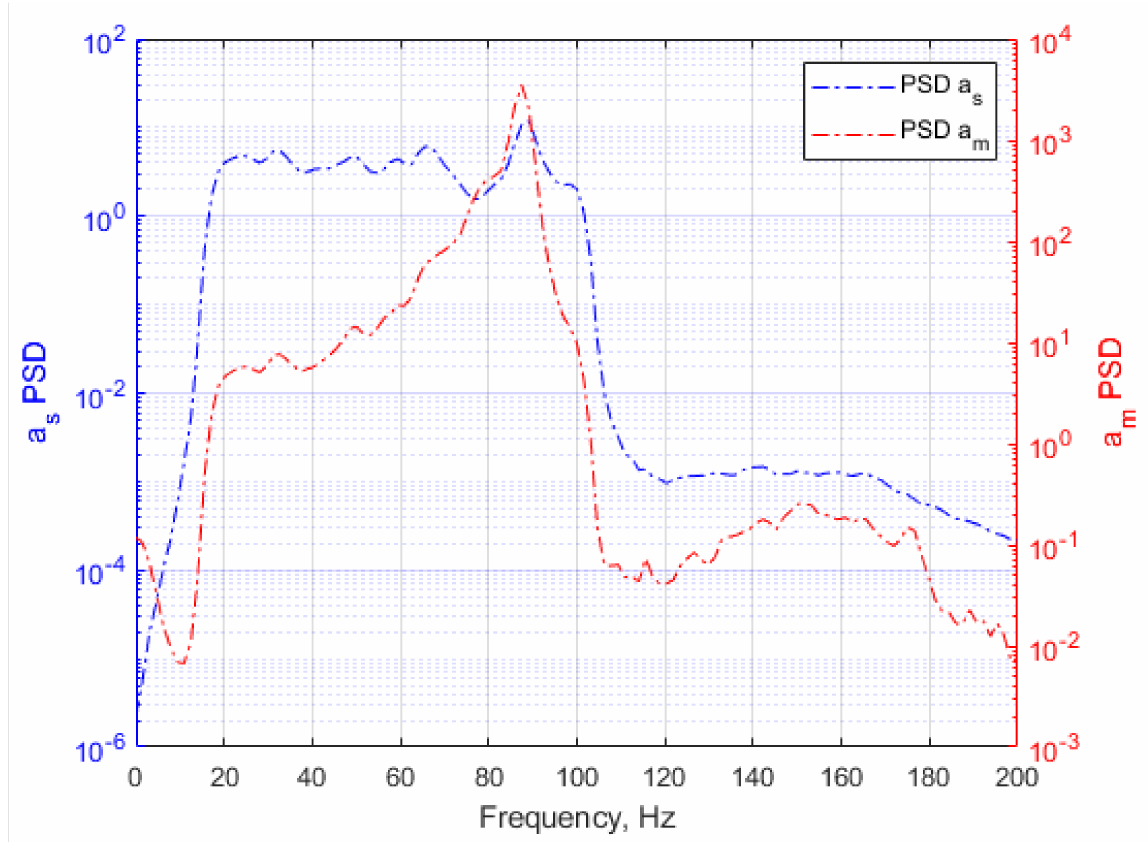
Figure 8. Power Spectral Density (PSD) for acceleration signals recorded during the test; kurtosis Ku = 3.